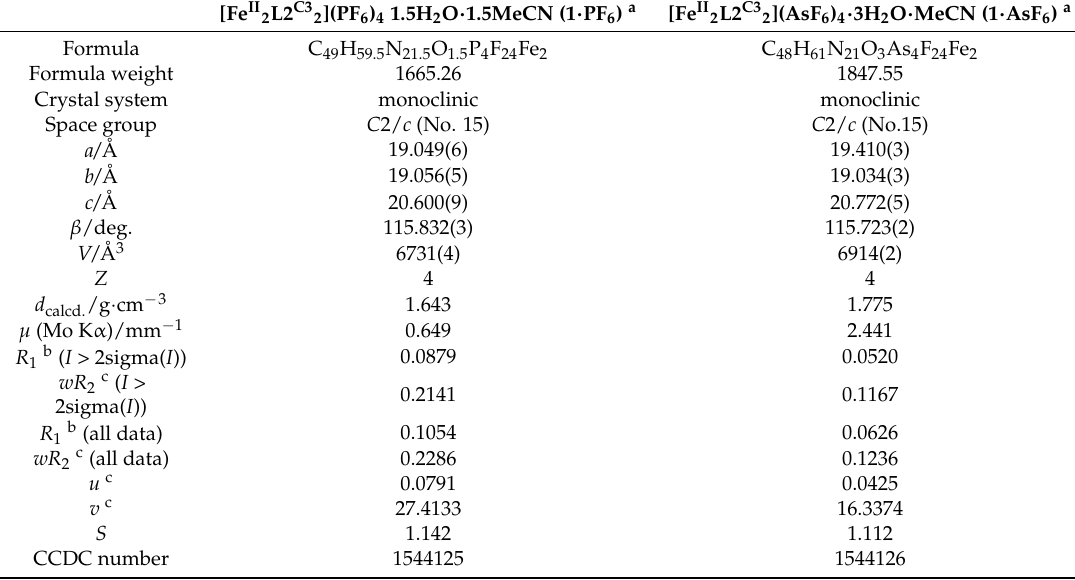
Table 1. X-ray crystallographic data for 1 · PF 6 and 1 · AsF 6 at 120 K.